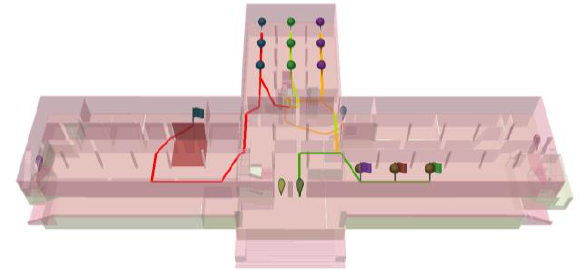
Figure 32. Generated Evacuation Ground Floor Routes of Library Staff for Third Evacuation